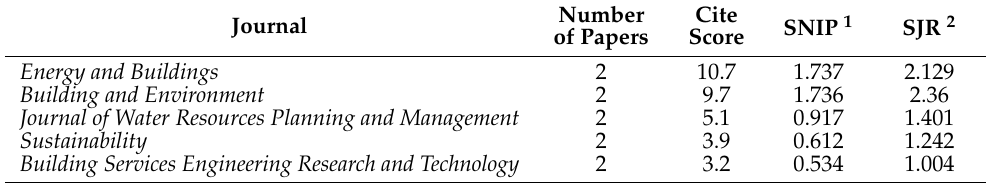
Table 1. International journals in which the majority of journal papers were